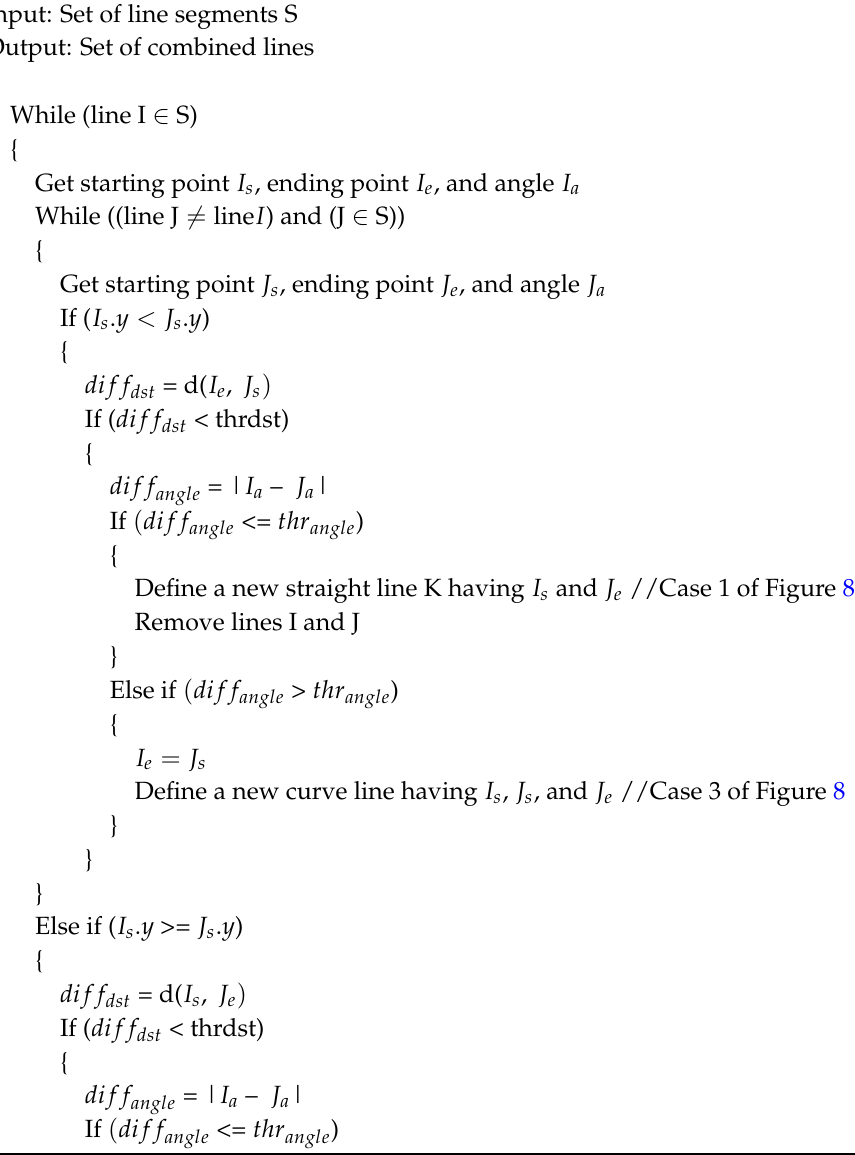
Algorithm 1. Line Combination